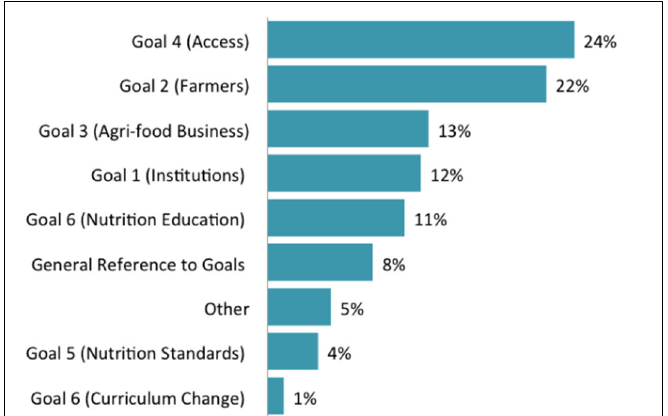
Figure 3. An Analysis of How Existing Stories Related